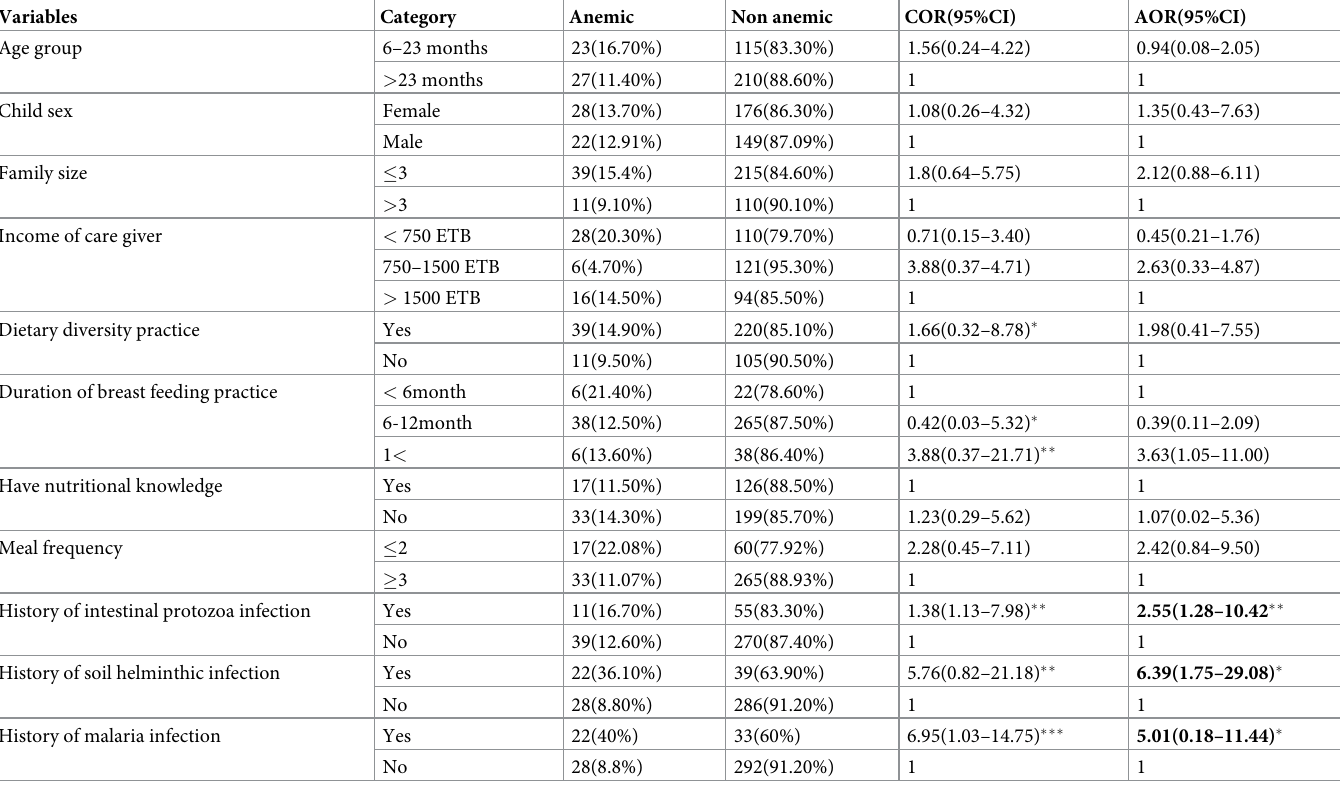
Table 4. Bivariate and multivariate analyses of factors associated with the prevalence of anemia among under-five year,